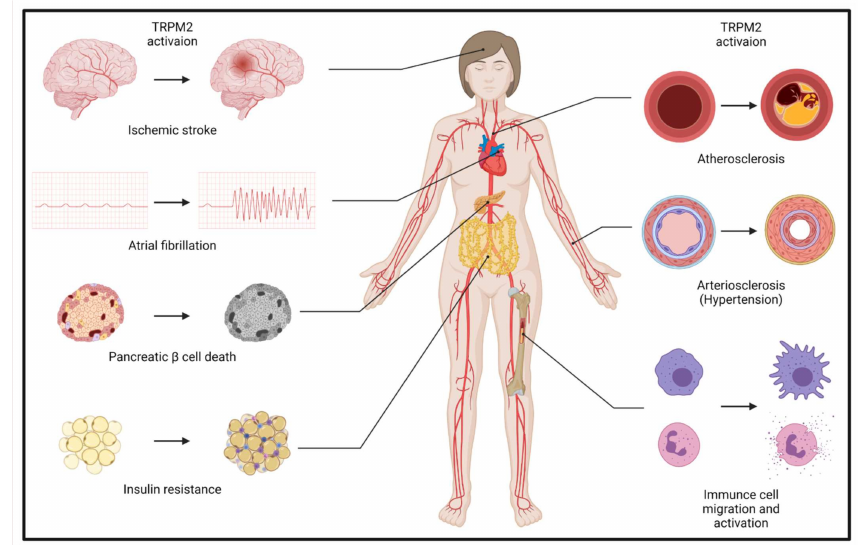
Figure 1. The comprehensive role of TRPM2 in ischemic